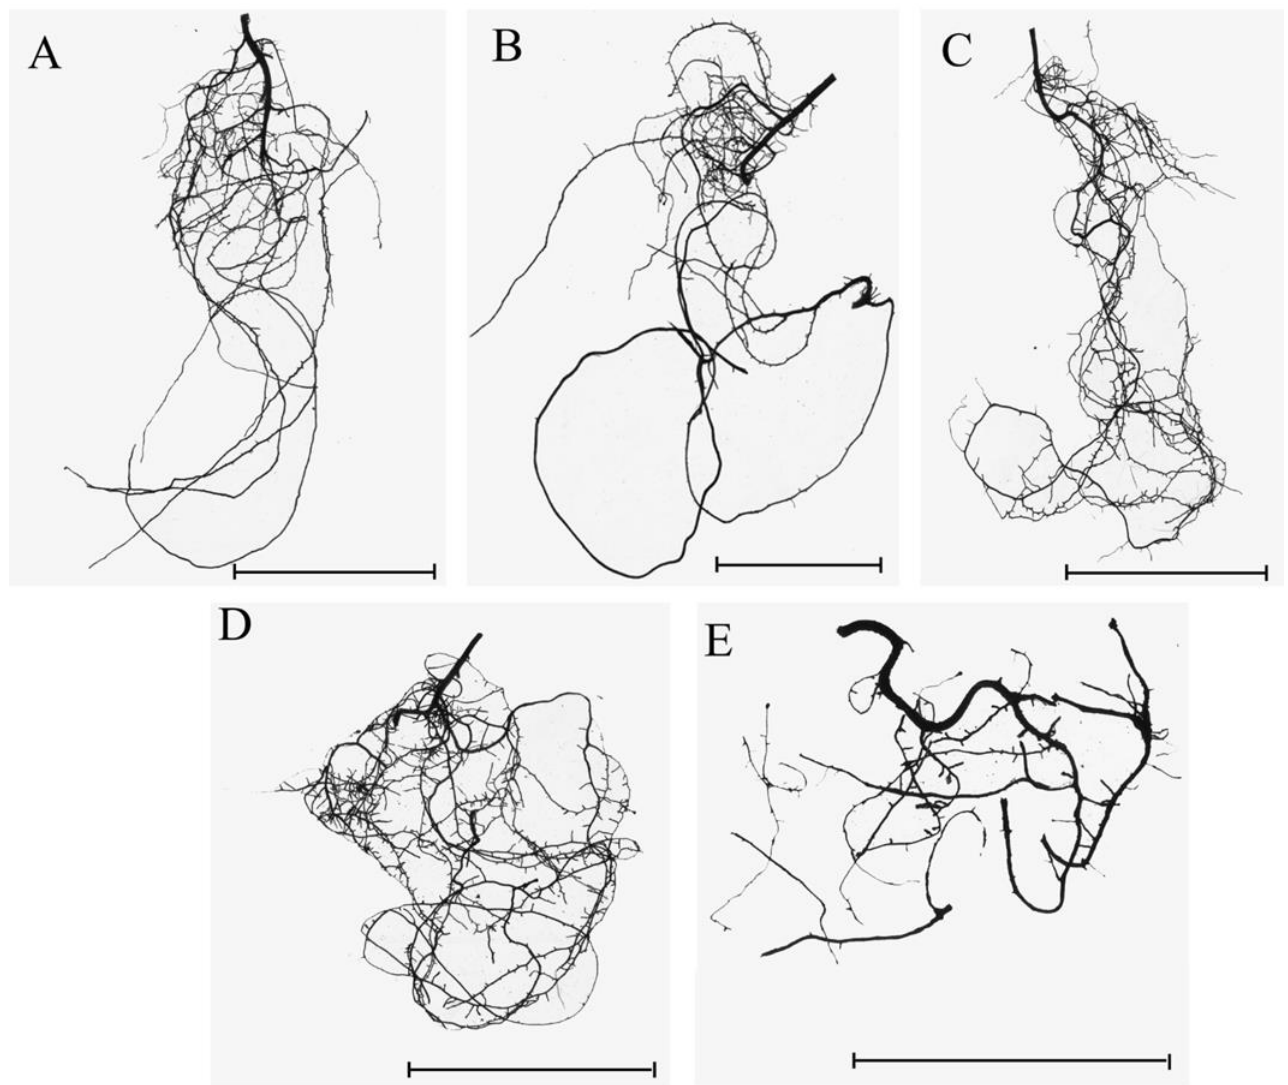
Figure 2. Examples of root system scans of silver fir seedlings with different treatments, 12 months after spore inoculation: ( A ) control treatment; ( B ) treatment with added common husks; ( C ) treatment with added Tartary buckwheat husks; ( D ) treatment with added common bran; ( E ) treatment with added Tartary buckwheat bran. The bar denotes a length of 5 cm.